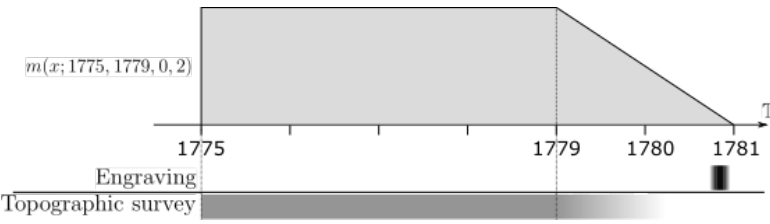
Figure 4. An uncertain valid time modelled as a trapezoidal fuzzy set